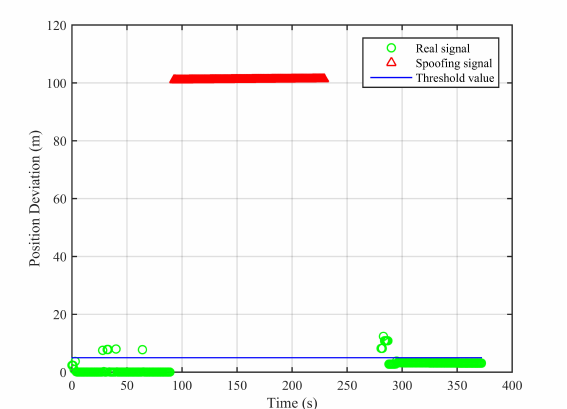
Figure 6. Position deviations of the two algorithms (Experiment No.